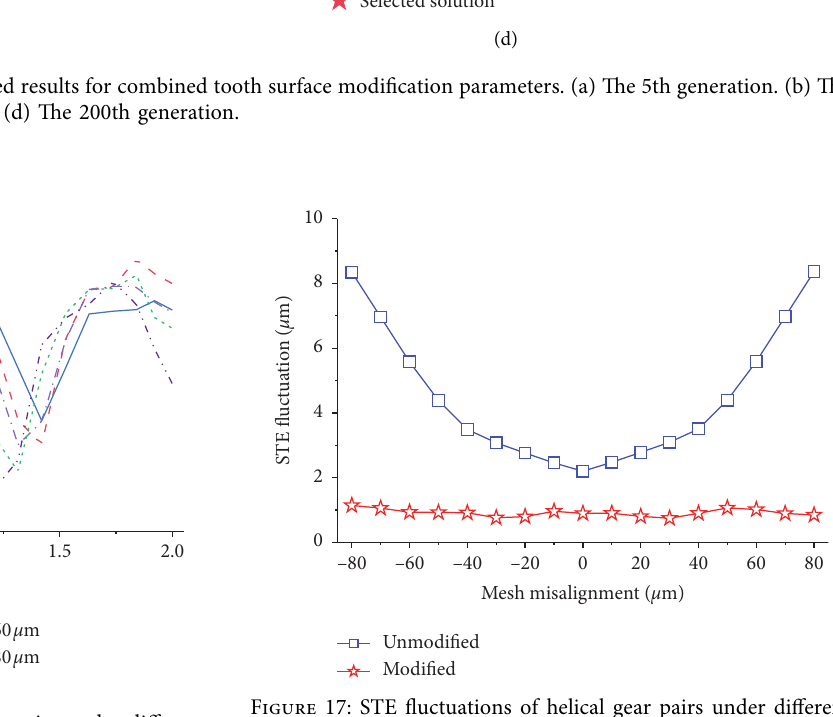
Figure 16: TDMS of modified helical gear pairs under different mesh misalignment conditions.